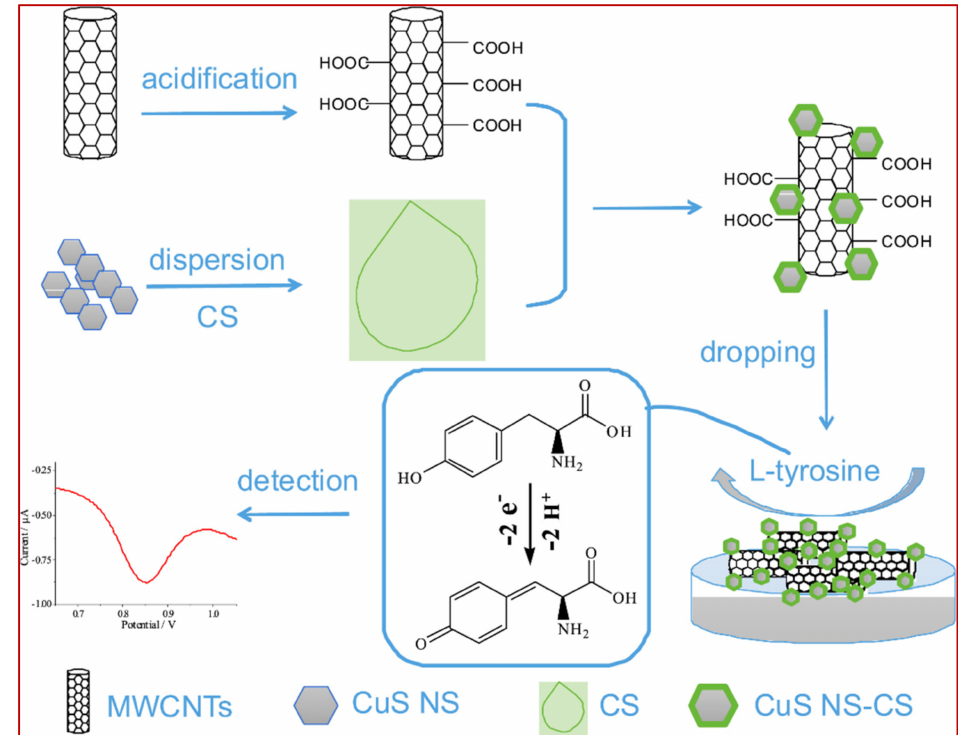
Figure 13. A schematic pathway of constructing the electrochemical Tyr sensor by dropping functionalized-MWCNT and CuS nanosheets in chitosan (CS) dispersions on a GCE surface. Adapted from. Reprinted with permission from ref. [351]. Copyright 2019